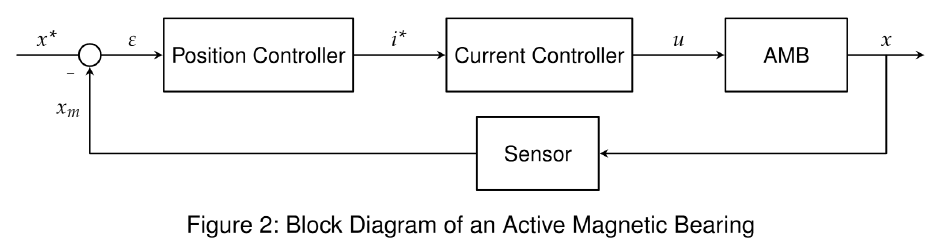
Figure 1. Block Diagram of Active Magnetic